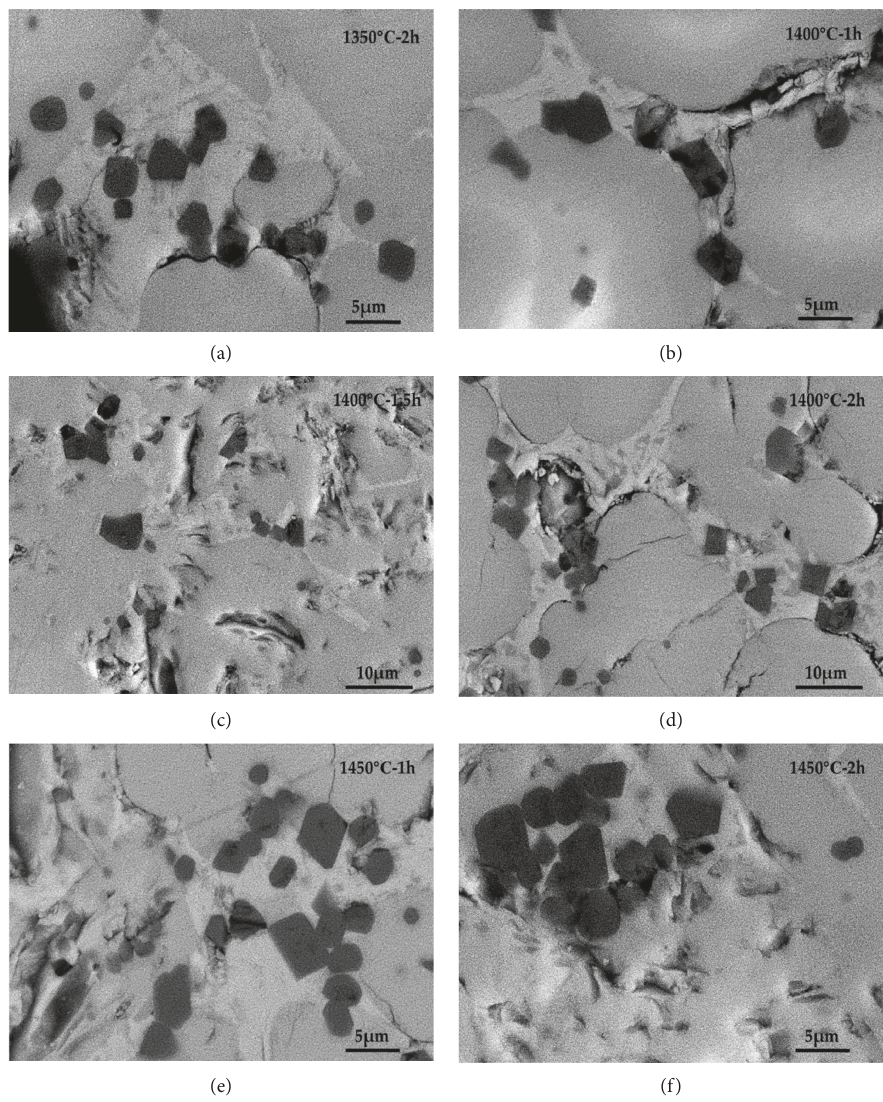
Figure 2: BSEM images of LHC clinkers calcined at 1350 ° C for 2.0 hours (a), 1400 ° C for 1.0 hour (b), 1400 ° C for 1.5 hours (c), 1400 ° C for 2.0 hours (d), 1450 ° C for 1.0 hour (e), and 1450 ° C for 2.0 hours (f) (the deep color particles represent periclase). Table 3: The particle size and the content of periclase in LHC clinkers calcined at different conditions. Calcination conditions Particle size of periclase ( μ m) Content of periclase